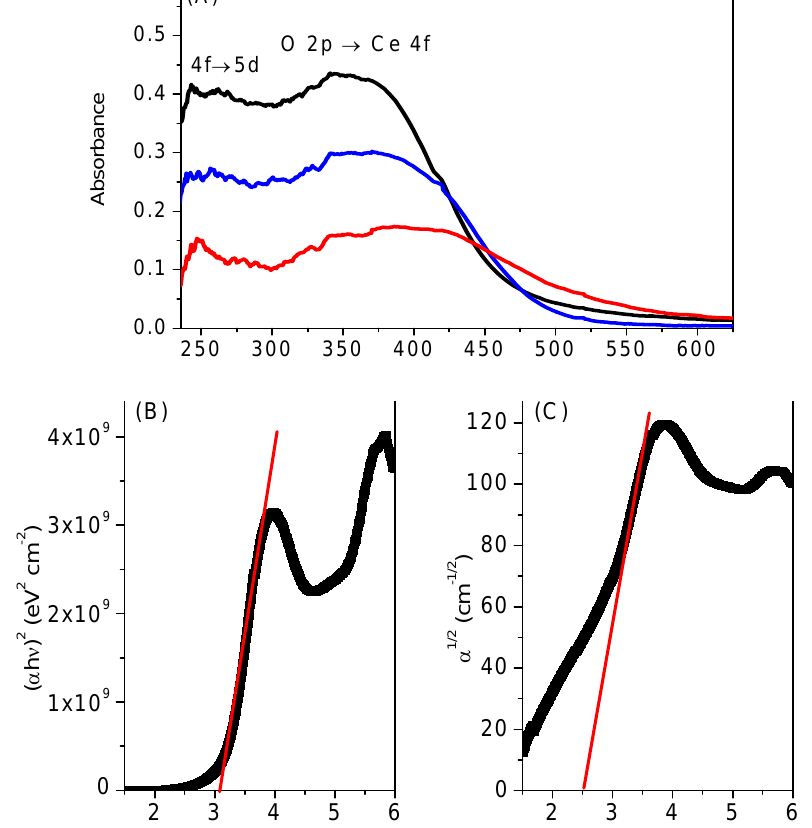
Figure 6. UV-Vis absorbance spectra of (A) CeNR (black), CeNR-BuOOH (blue) and CeNR-H O (red) powders. Plots of (B) ( α h ν ) 2 versus (h ν ) and (C) α 1/2 versus (h ν ) for the 2 2 CeNR ethanol suspension.